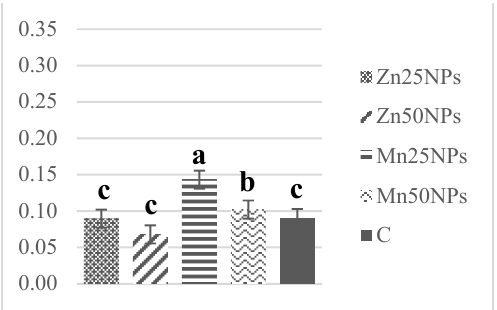
Figure 12. SOD activity (U/mg) in samples of turkey sperm stored for 48 h with or without (C) the Figure 11. SOD activity (U/mg) in samples of turkey sperm stored for 24 h with or without (C) the addition of ZnNPs and MnNPs. * Different letters (a, b, c) indicate statistically significant differ- Figure 11. SOD activity (U/mg) in samples of turkey sperm stored for 24 h with or without (C) the Figure 11. SOD activity (U/mg) in samples of turkey sperm stored for 24 h with or without (C) the addition of ZnNPs and MnNPs. * Different letters (a, b, c) indicate statistically significant differences ences at p ≤ 0.05. The bars with various letters are significantly different from one another. addition of ZnNPs and MnNPs. * Different letters (a, b, c) indicate statistically significant differ- addition of ZnNPs and MnNPs. * Different letters (a, b, c) indicate statistically significant differ- at p ≤ 0.05. The bars with various letters are significantly different from one another. ences at p ≤ 0.05. The bars with various letters are significantly different from one another. ences at p ≤ 0.05. The bars with various letters are significantly different from one another.